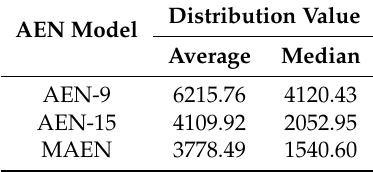
Table 3. Image reconstruction performance.